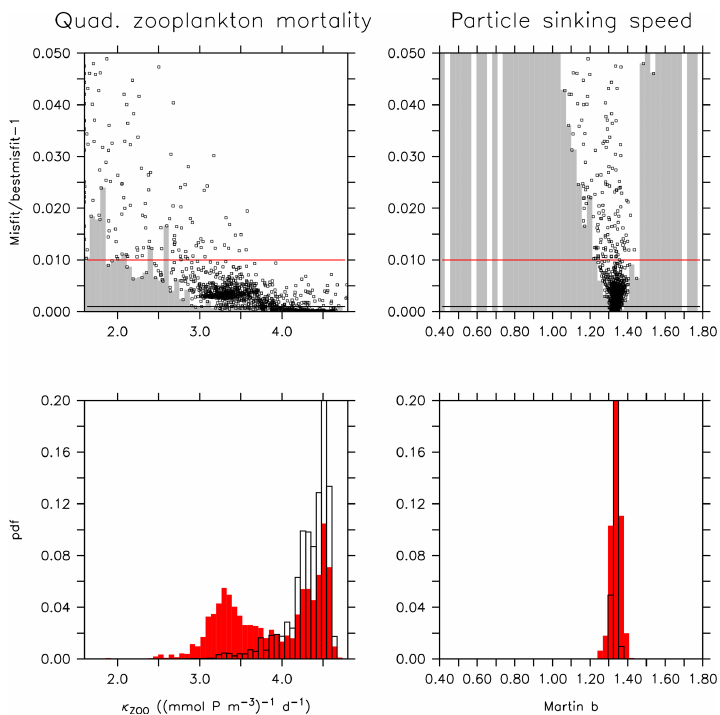
Figure 8. Projections from the parameter–cost function manifold ( b (cid:50) l , J( (cid:50) ) ) as obtained during the optimization of six biogeochemical parameters. Parameters shown are quadratic zooplankton mortality κ zoo (left panels) and rate of vertical increase in particle sinking speed, a , expressed as quotient b = r/a , where r is the particle remineralization rate (right panels). Upper panels: cost function (volume-weighted root-mean square error, divided by the global mean concentration of each tracer) expressed as its deviation from the minimum. Parameters of all model simulations in the optimization trajectory were grouped into 50 classes. Grey bars show the minimum cost within each class. Red and black horizontal lines indicate deviations from the minimum cost of 1% and 0.1% respectively. Squares show the cost of each individual. Note that the y axis only extends to 5% above the minimum cost at ( b (cid:50) , J( b (cid:50) ). Lower panels: parameter distribution (PDF) of all model simulations whose costs do not exceed a threshold limit of (cid:49) J = 1.01 · J( b (cid:50) ) (1%, red bars) or (cid:49) J = 1.001 · J( b (cid:50) ) (0.1%, open bars): 0.1% (open bars) of the minimum cost; see Eq. (16) and the